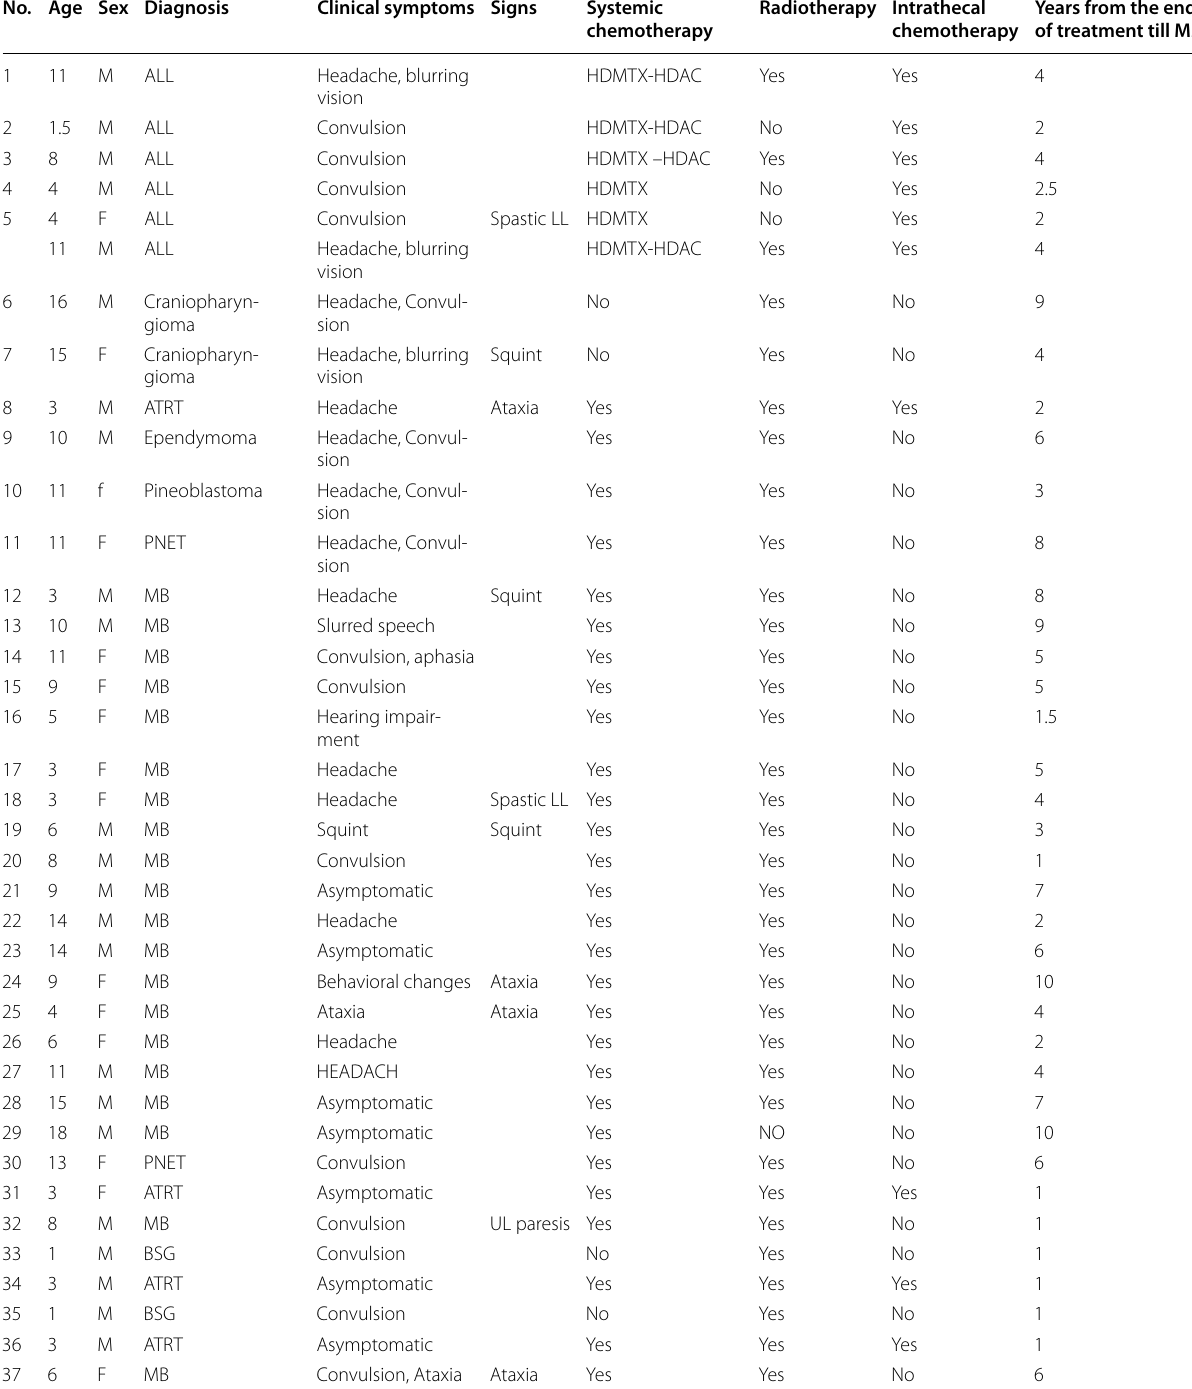
M; Male F; female ALL; acute lymphoblastic leukemia, MB; medulloblastoma, ATRT; atypical tetartoid rhabdoid tumor, PNET; primitive neuroectodermal tumor, BSG; brain stem glioma, HDMTX; high-dose methotrexate, HDAC; high-dose Ara C. UL; upper limb, LL; lower limb